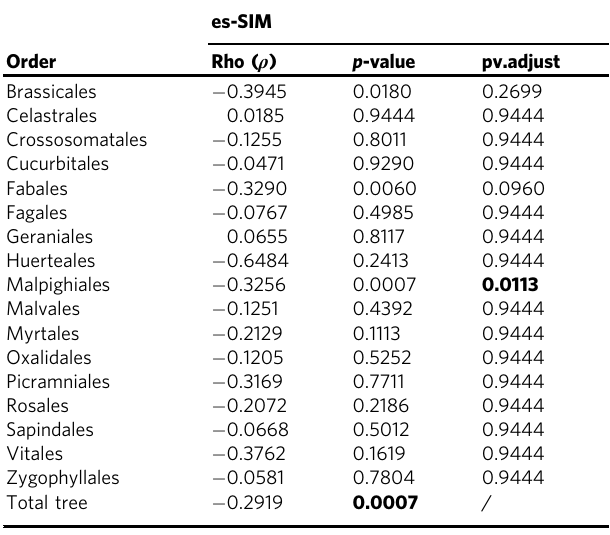
Table 1 Summary table of semi-parametric tests for correlation between diversi fi cation rate and continuous mean annual temperature